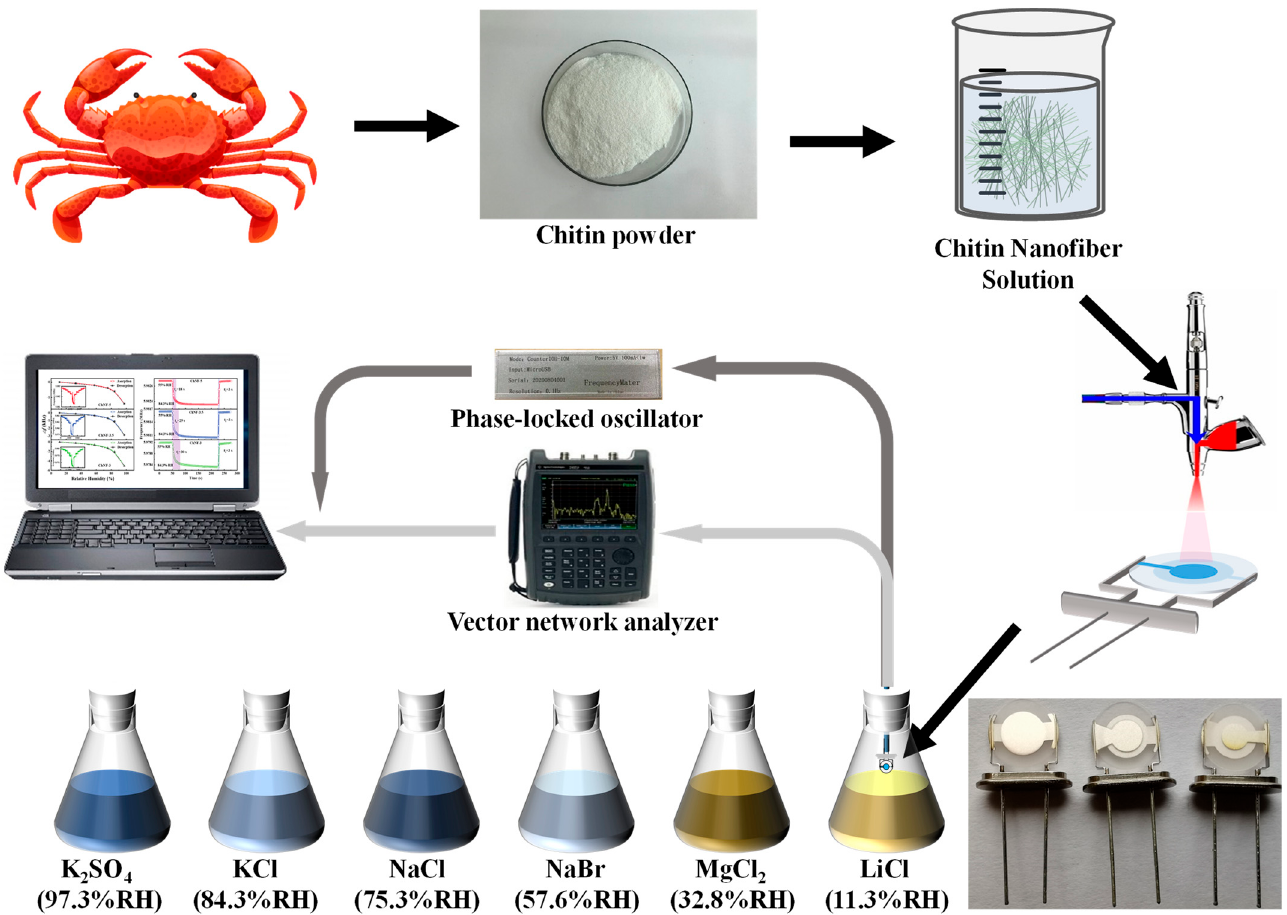
Figure 2. Schematic diagram of the experimental setup. Table 1. Equivalent circuit parameters of the bare QCM in the